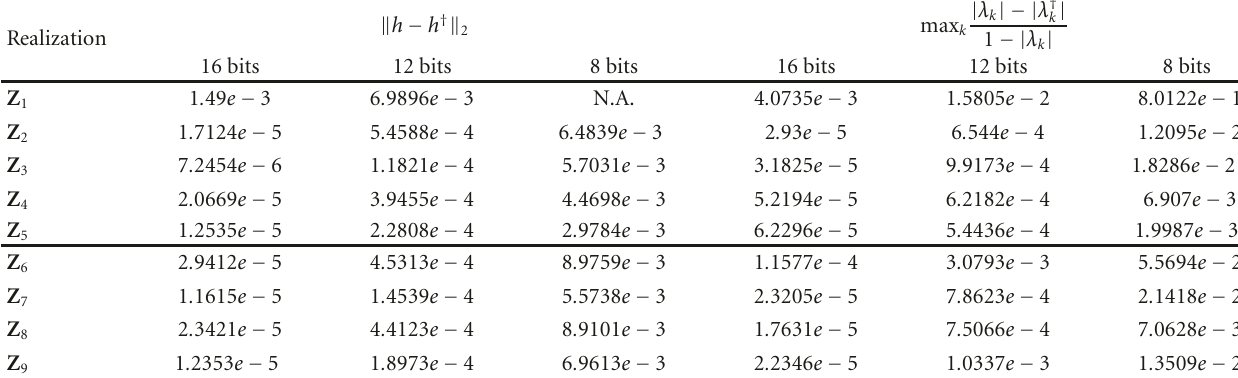
Table 3: Transfer function and pole errors of the quantized realizations.